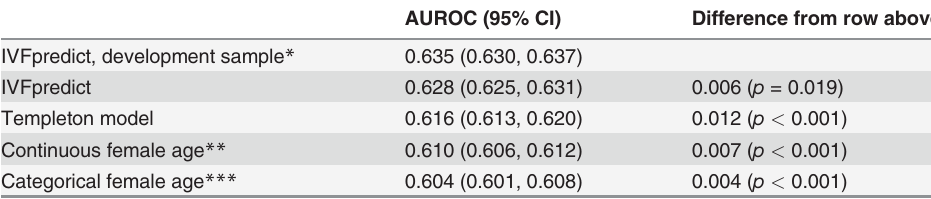
Table 2. Area under the receiver-operator curve for IVFpredict and Templeton models, and female age alone, for predicting live birth from 130,960 IVF cycles.